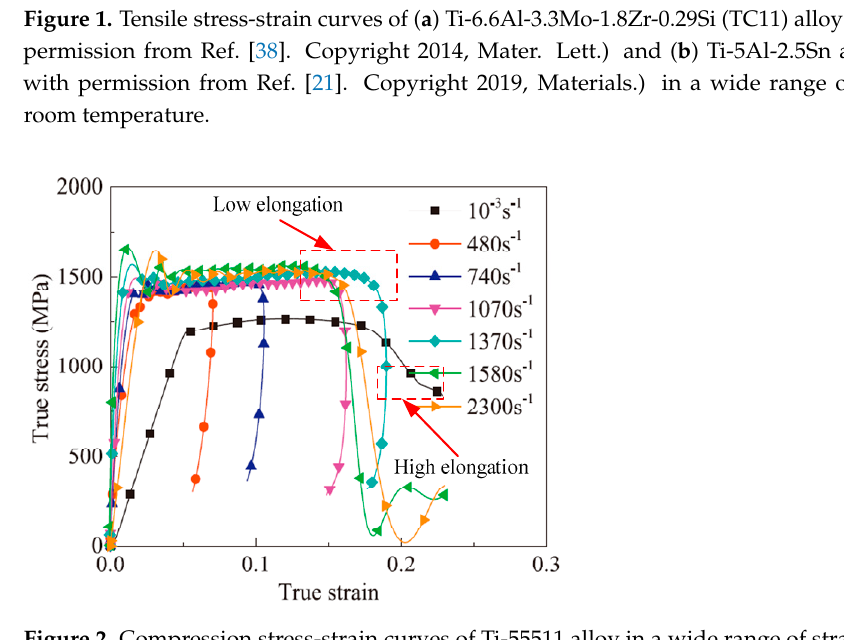
Figure 3. Relationship between strain rates, deformation velocities and uniform strain of Ti-6Al-4V alloy rings obtained from electromagnetic bulging experiments (Reprinted with permission from Ref. [40]. Copyright 2014, 11th International Conference on Technology of Plasticity). Current investigations of flow stress behaviors of titanium alloys at different strain rates mainly focus on the variation law of yield and tensile strength. Considering the tita- nium alloys with hexagonal closed-packed phases, the yielding and hardening behaviors show anisotropic characteristics within different strain rates at room temperature [34,41]. Gilles et al. conducted a uniaxial tensile test of Ti-6Al-4V alloy at room temperature and obtained the yield stress in different loading directions and the corresponding yield loci at a strain rate of 3.1 × 10 − 4 s − 1 [42], as shown in Figure 4a. It was found that the yield stress will initially increase and then decrease in the range of 45 degrees. Tang et al. reported that the yield stress presents a monotonic decrease with an increase in the directional de- grees under tension at higher loaded strain rate of 0.1 s − 1 [43]. Furthermore, the yield loci at different loaded strain rates has been reported to enhance the symmetry of ellipse at higher strain rates, as shown in Figure 4b. In contrast to the yield behaviors of titanium alloys, Zhang et al. discovered that the initial yield stress would increase with the increase in strain rates through the implementation of uniaxial tensile tests of Ti-5Al-2.5Sn alloy